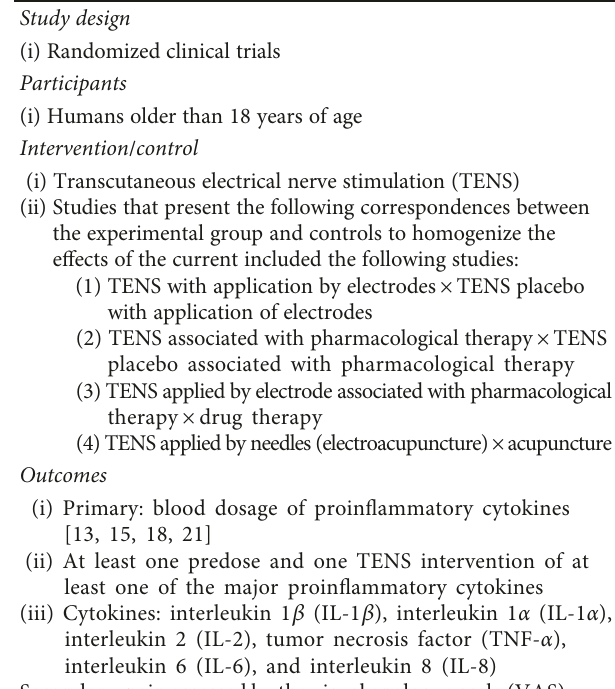
Table 1: Inclusion